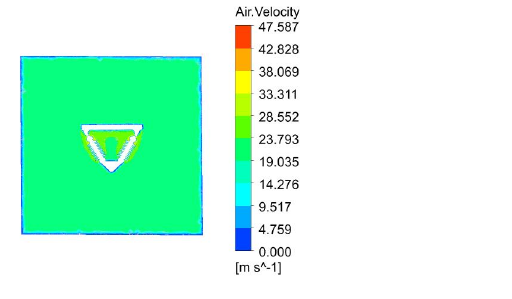
Figure 30. Cloud map of plane velocity distribution at frontal viewing angle.